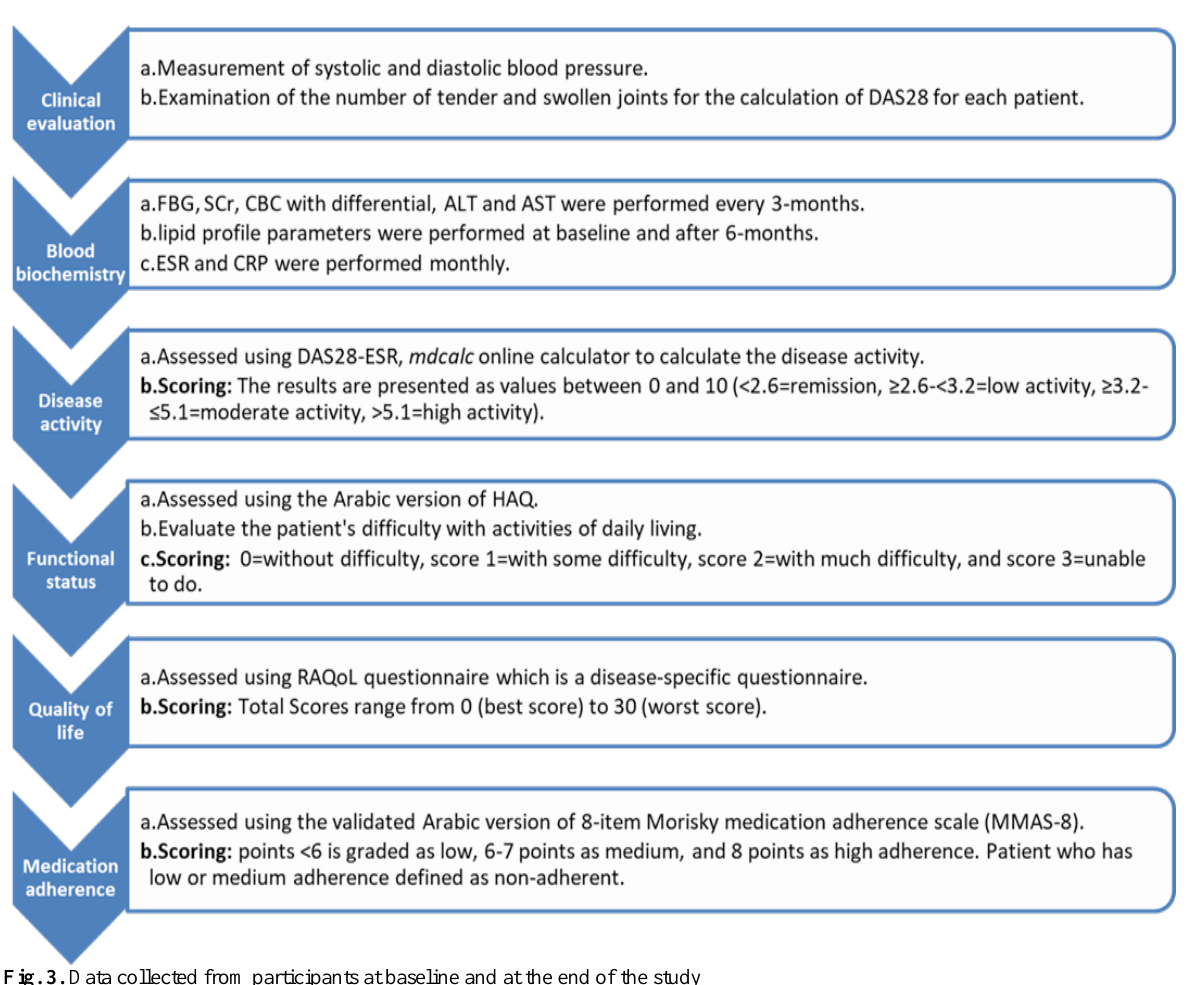
Fig. 3. Data collected from participants at baseline and at the end of the